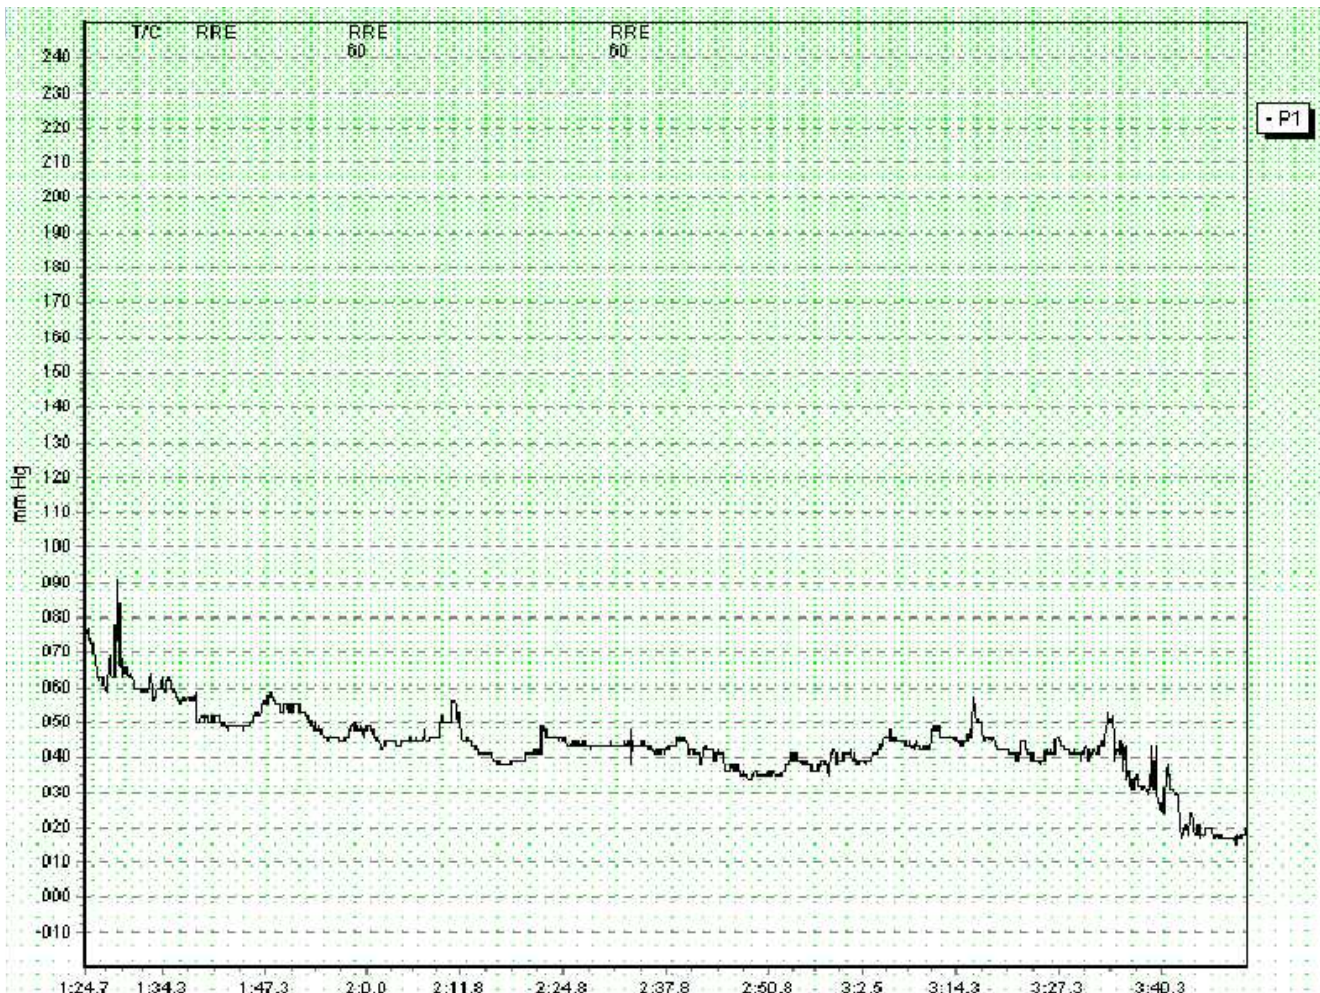
FIGURE 2 - Computarized anorectal manometry using the baloon